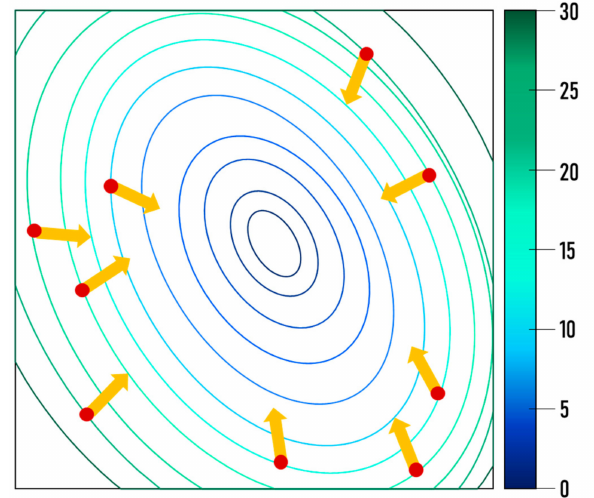
Figure 9. Particle swarm optimization (PSO)